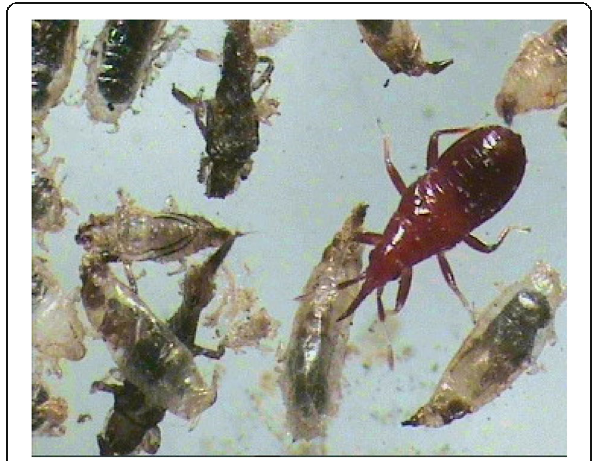
Fig. 1 The third nymphal instar of M. moraguesi feeding on pupae of the parasitoid P. thysanopterus inside prepupal shell of G.